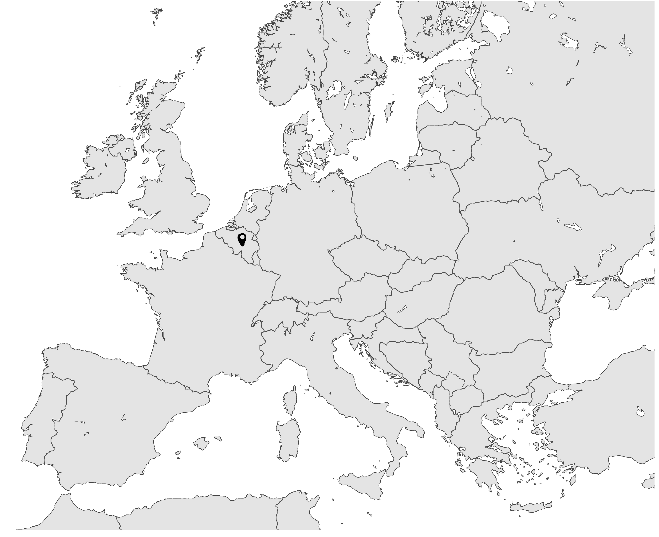
Figure 3. Localisation of the city of Erpent (Wallonia, south part of Belgium) (Reprinted from Ref. [23]).